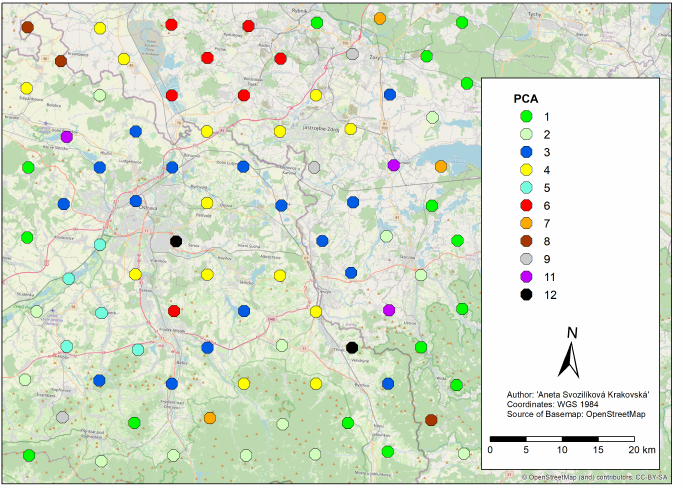
Figure 12. The result of the principal components